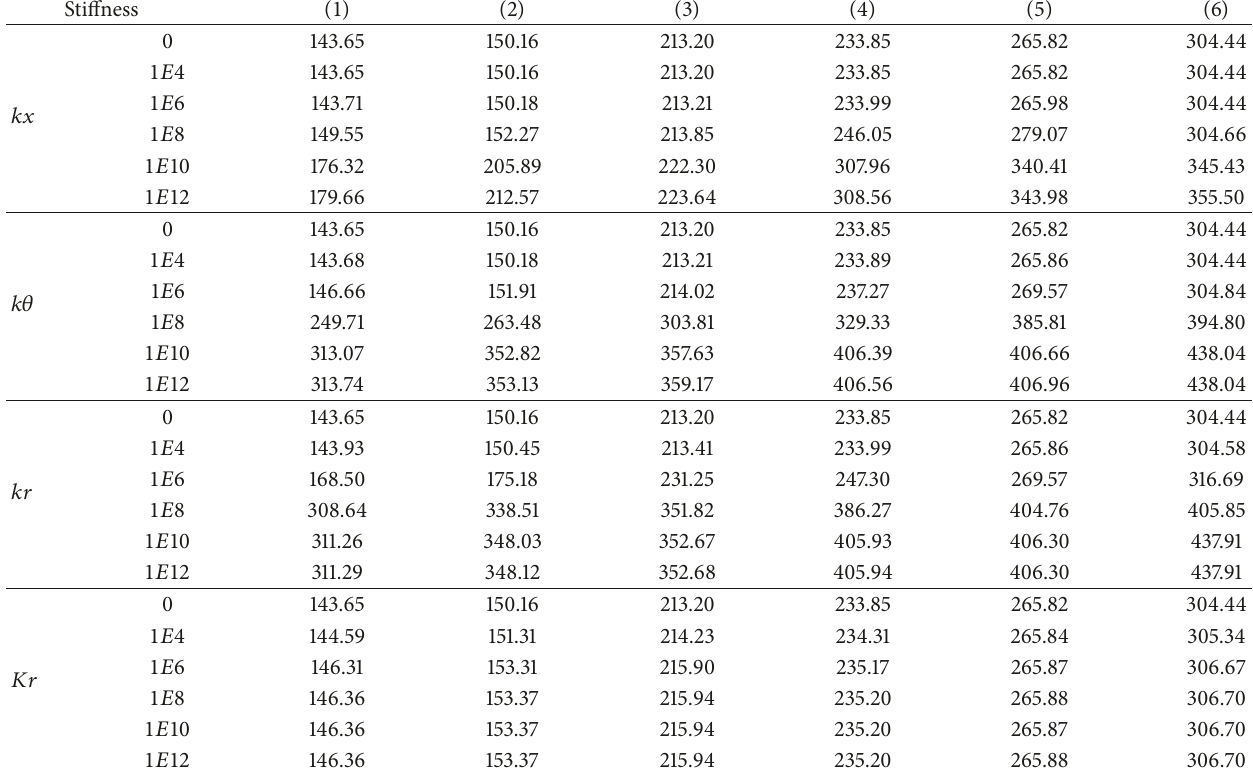
Table 4: Natural frequencies for a clamped, elastically supported shell 𝑓 /Hz.